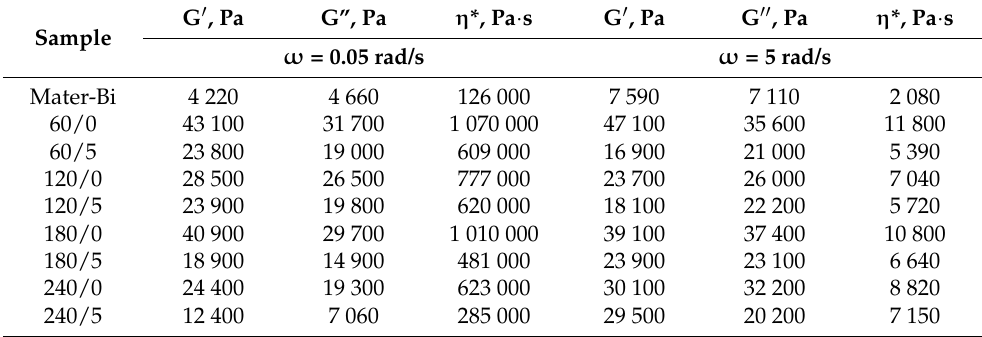
Table 7. Storage (G (cid:48) ) and loss (G”) moduli and complex viscosity ( η *), measured at angular frequen- cies of 0.05 and 5